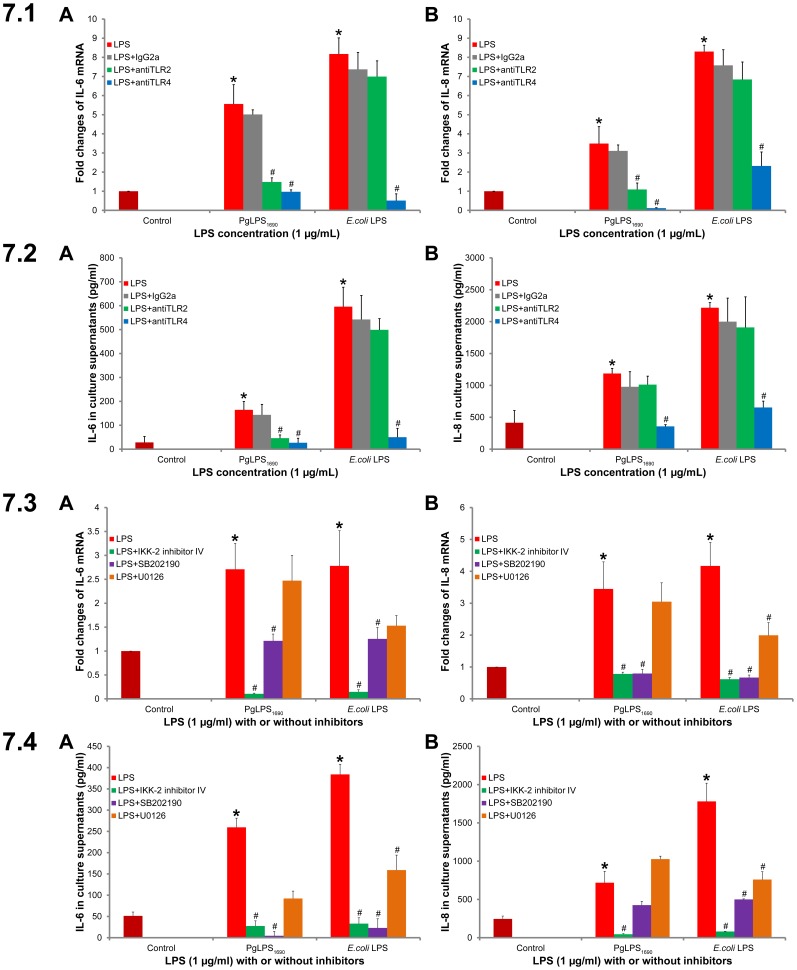
Blocking assay on the involvement of TLR2/TLR4 and signal transduction pathways in P. gingivalis (Pg) LPS1690 (PgLPS1690)- and E. coli LPS-induced expression of IL-6 and IL-8 in HGFs.The cells were pretreated for 1 h with anti-TLR2 and anti-TLR4 antibodies in serum free medium, and then treated with PgLPS and E. coli LPS at 1 µg/ml for additional 12 h. Total RNA and cell culture supernatants were collected and analyzed for IL-6 (A) and IL-8 (B) by quantitative real-time PCR and ELISA, respectively. The histograms show IL-6 (7.1A) and IL-8 (7.1B) mRNA levels of three independent experiments, and IL-6 (7.2A) and IL-8 (7.2B) protein expression levels of two independent experiments. The results were presented as mean ±SD. Calculation of significant difference were made in comparison to the controls without LPS treatment (*p-value <0.05) or the cells treated with LPS alone (#p-value <0.05). Cells were pretreated with IKK-2 inhibitor IV (IKK-β inhibitor), SB202190 (p38 MAPK inhibitor) and U0126 (ERK inhibitor) in serum free medium for 1 h, then treated with PgLPS and E. coli LPS at 1 µg/ml for additional 12 h. The histograms show IL-6 (7.3A) and IL-8 (7.3B) mRNA levels of three independent experiments, and IL-6 (7.4A) and IL-8 (7.4B) protein expression levels of two independent experiments. The results were presented as mean±SD. Calculation of significant difference were made in comparison to the controls without LPS treatment (*p-value <0.05) or the cells treated with LPS alone (#p-value <0.05).